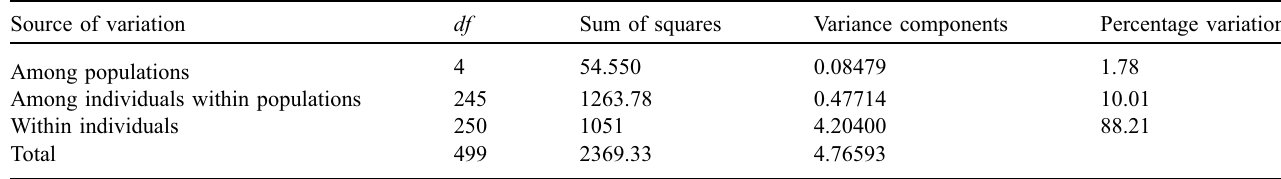
Table 3. One way AMOVA based on microsatellite markers in S. commerson populations.